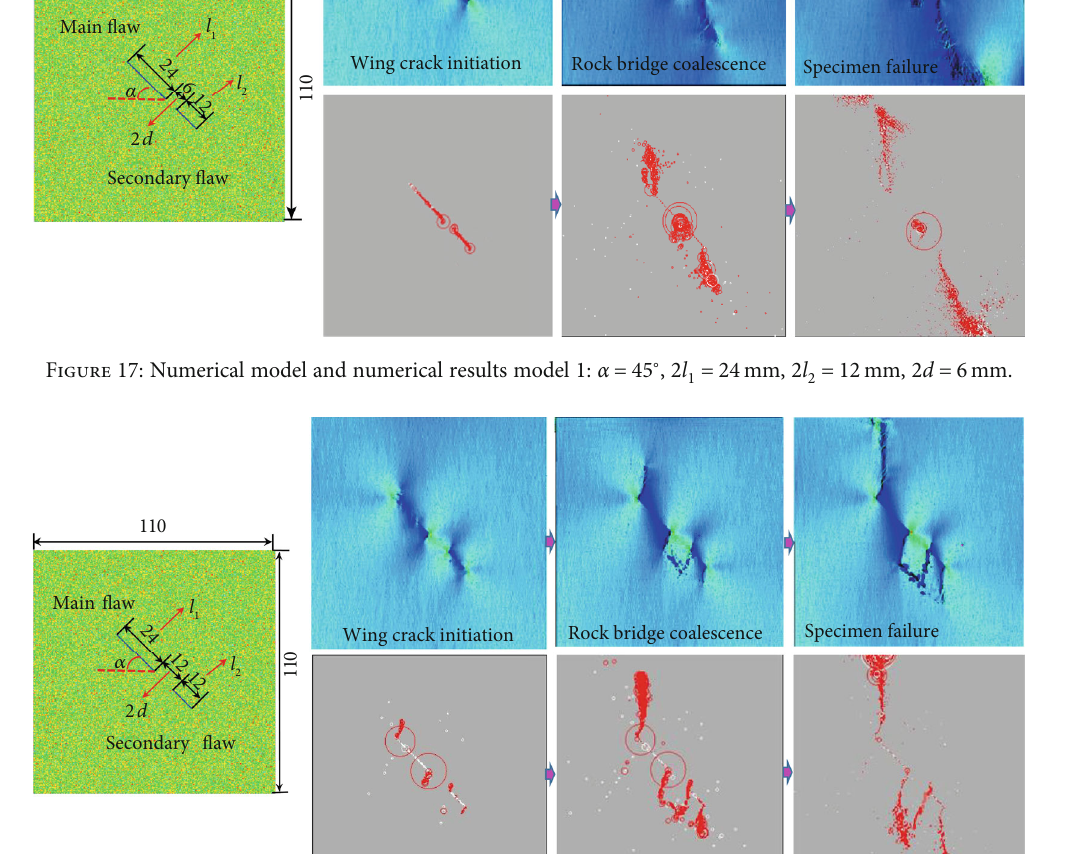
Figure 18: Numerical model and numerical results model 2: α = 45 ° , 2 l